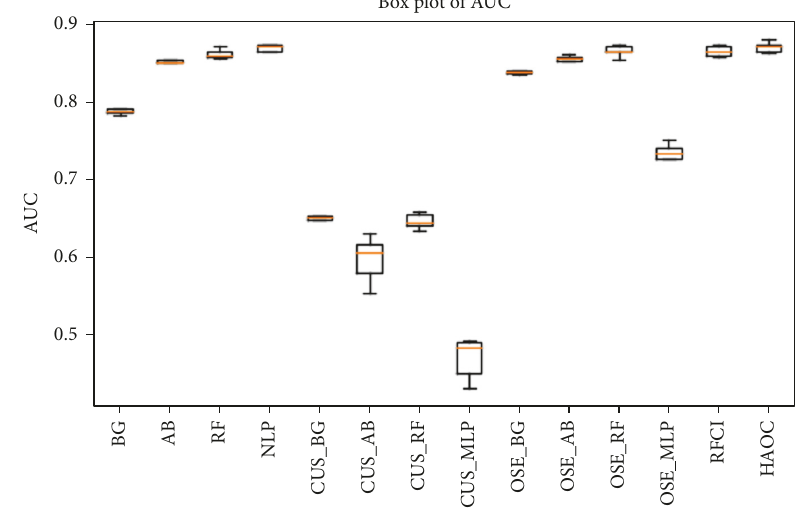
Figure 8: The box plot in terms of AUC of experimental approaches for KRBDS in five folds.